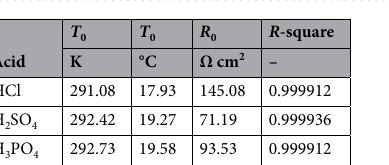
Figure 7. Linear correlation between the product temperature-charge transfer resistance T · R ct and the charge transfer resistance R ct for each acid.